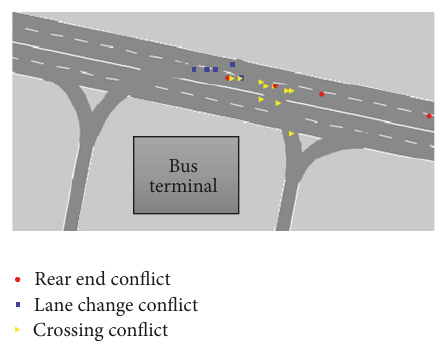
Figure 9: Conflicts near bus terminal plots on original network.